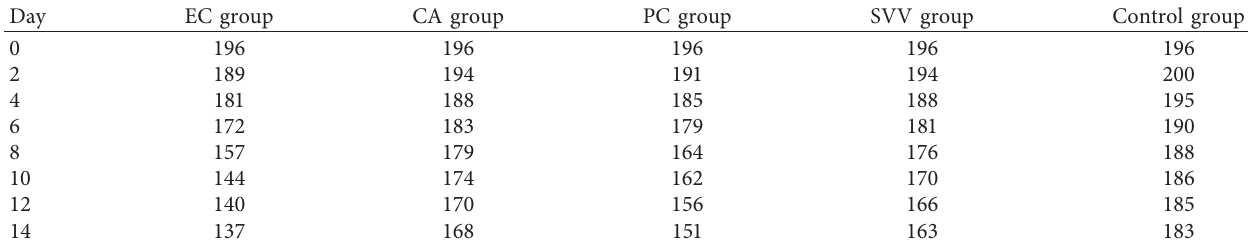
Figure 2: Changes in the total content of wastewater treated by plants. Table 4: Data table of changes in COD content of sewage treated by plants.